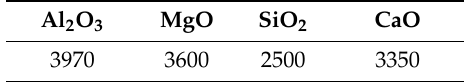
Table 3. The densities of simple oxide inclusions (kg / m 3